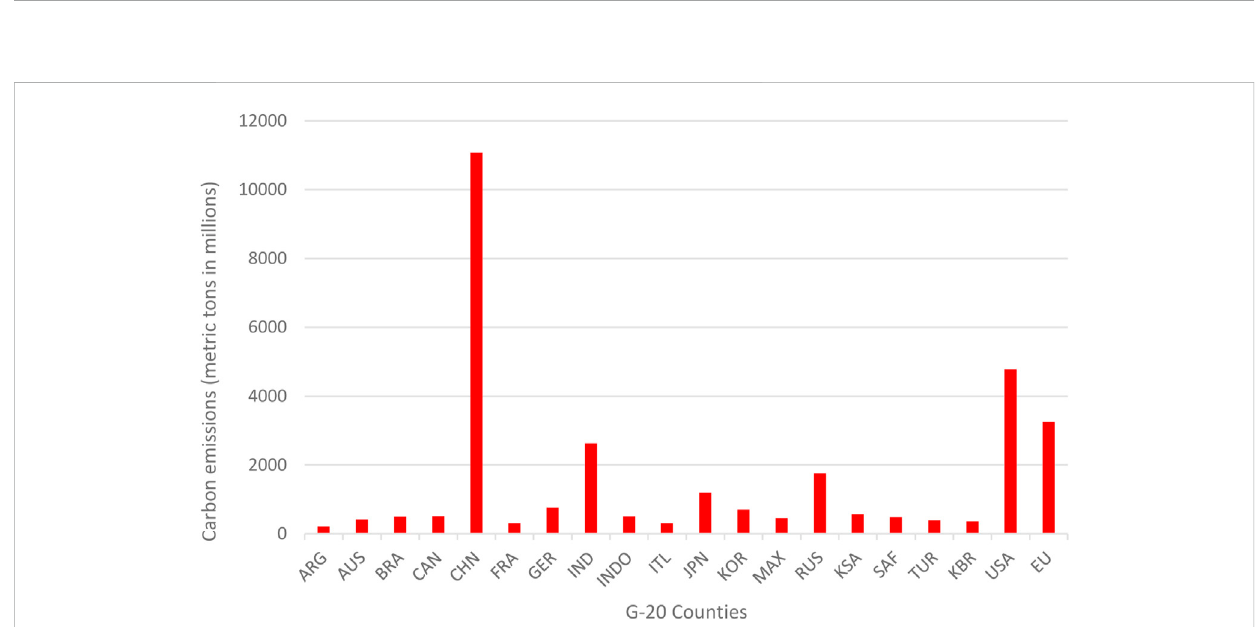
FIGURE 2 Carbon emissions status (metric tons in millions) of G-20 countries based on